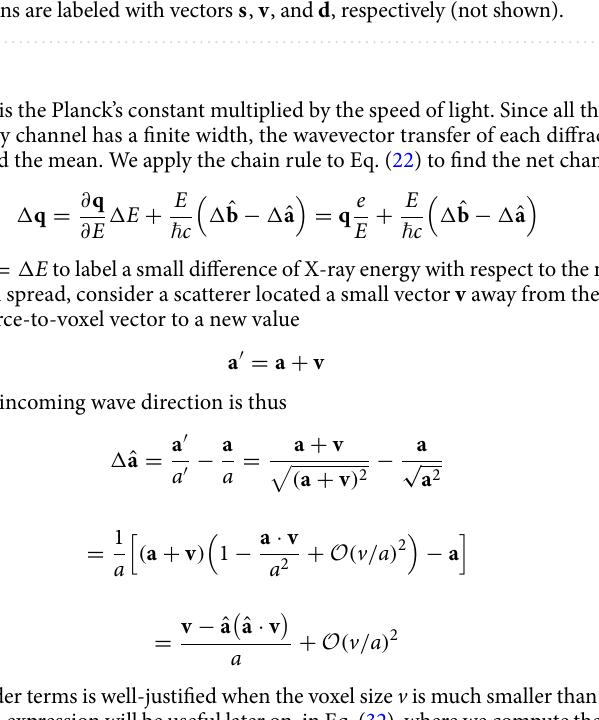
Figure 7. A typical scattering geometry, defined by the incoming generality, the two vectors are unequal. We also show the principal directions S , V , and D which cause the main uncertainty (cid:31) q (see Eq. (32)). The large circles illustrate the finite-sized source, voxel, and detector regions. Note that in general the three regions can have arbitrary, non-circular shapes as described in Eqs. (34)–(37). Specific points within those regions are labeled with vectors s , v , and d , respectively (not